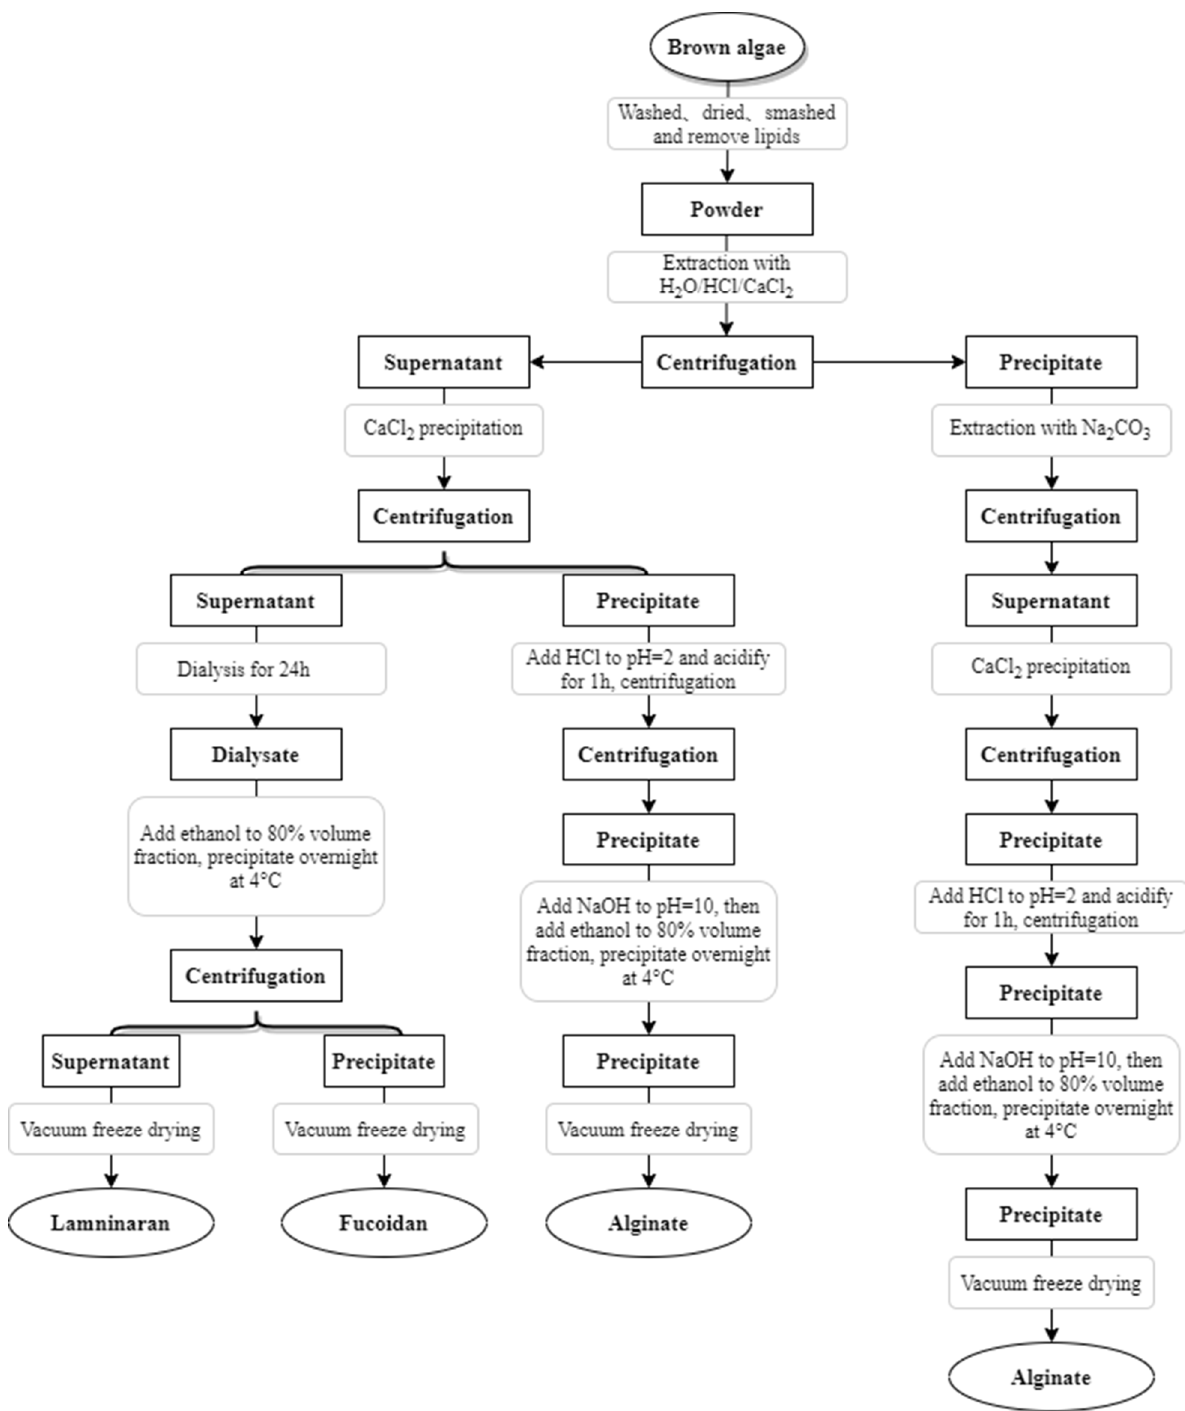
Figure 5. Extraction and separation process of brown algae polysaccharide.